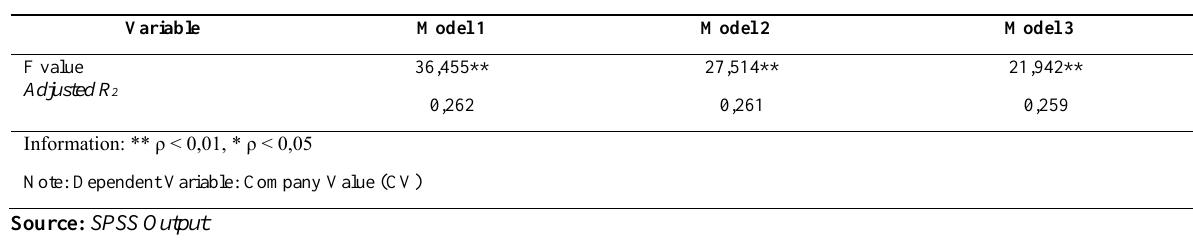
Table 3: Goodness of Fit